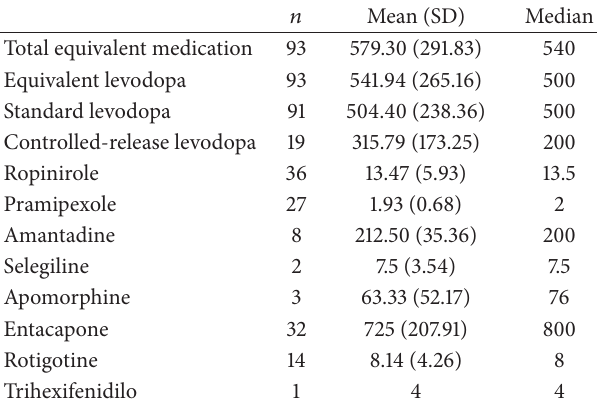
Table 7: Medication